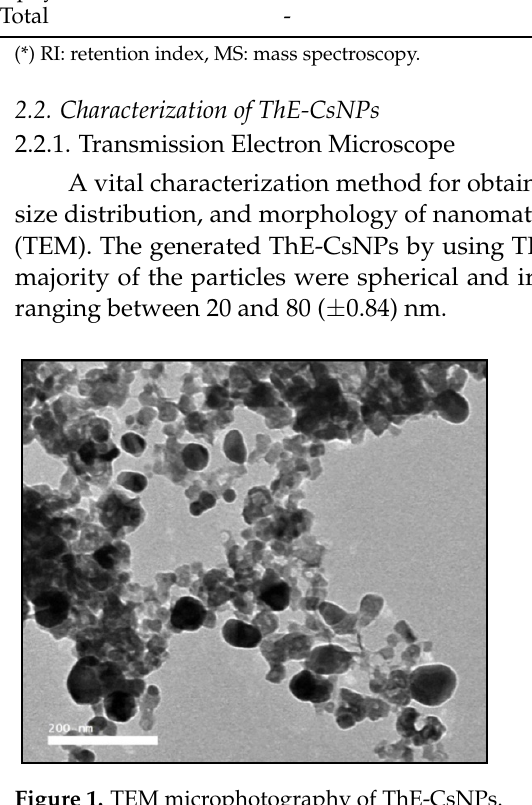
Figure 1. TEM microphotography of ThE-CsNPs.